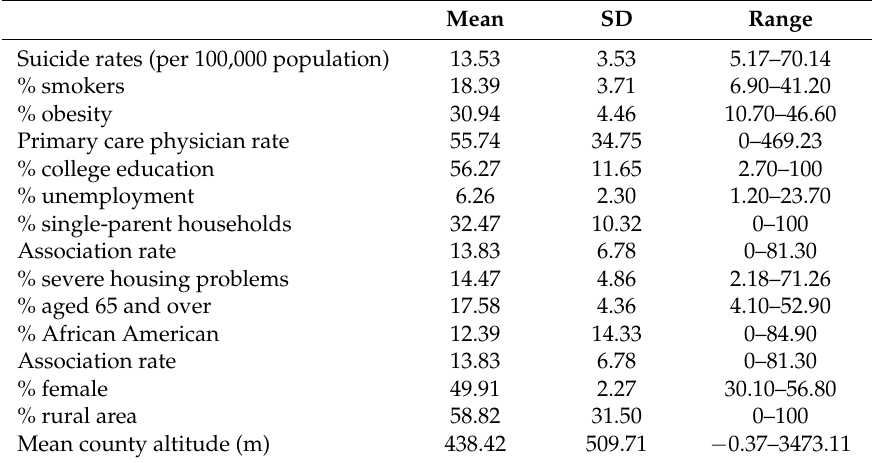
Table 3. Descriptive statistics for dependent and independent variables for